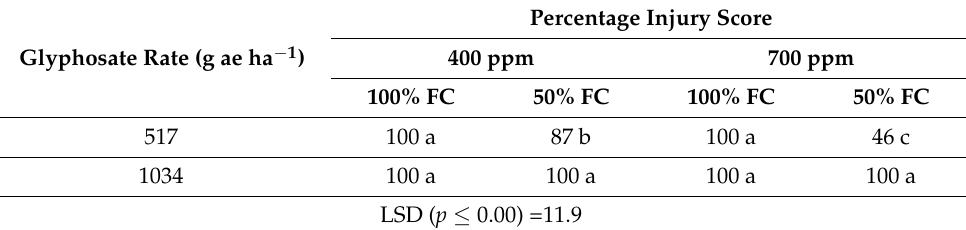
Table 2. Effect of different herbicide rates on the weed control (injury score) of S. cannabina under different [CO 2 ] and soil moisture conditions. The experiment was repeated, and the pooled data from the two studies are presented